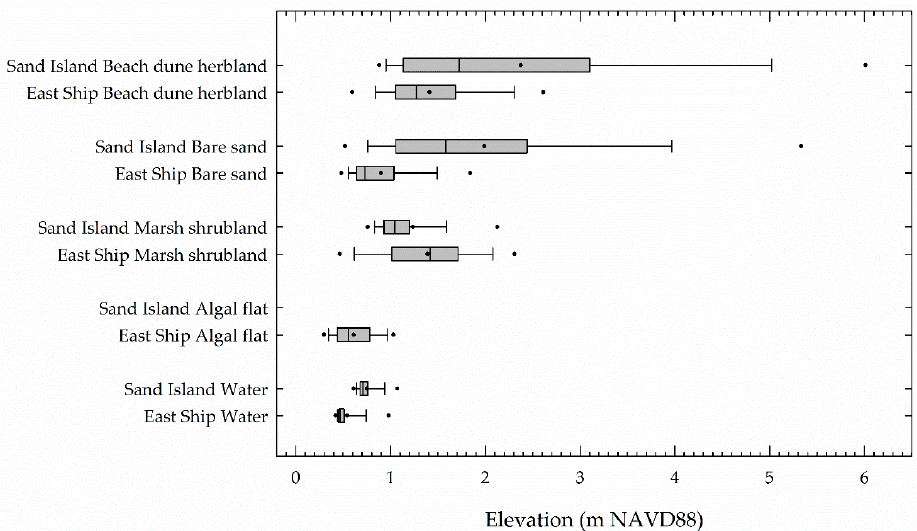
Figure 6. Box and whisker plot showing the relationship between habitat (2012 ML classification) and elevation (2012 DTM) on both islands. The line and dot within each box represent the median and mean, respectively. Box widths represent the middle 50% of the data about the median; 75% of the data lie between the horizontal bars (“whiskers”). The dots outside the horizontal bars represent the extreme minimum and maximum 5% and 10% of the data.